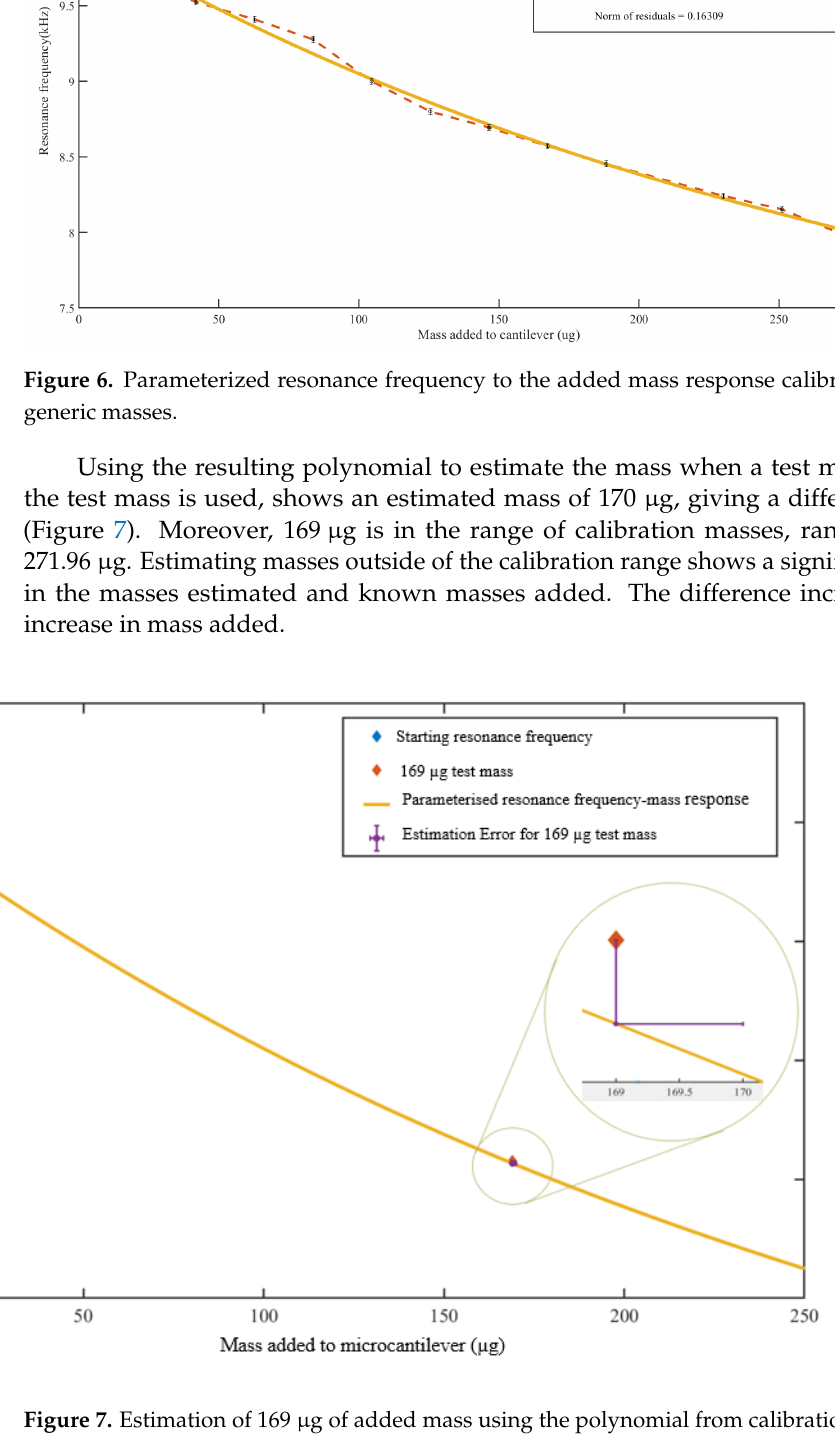
Figure 7. Estimation of 169 µ g of added mass using the polynomial from calibration